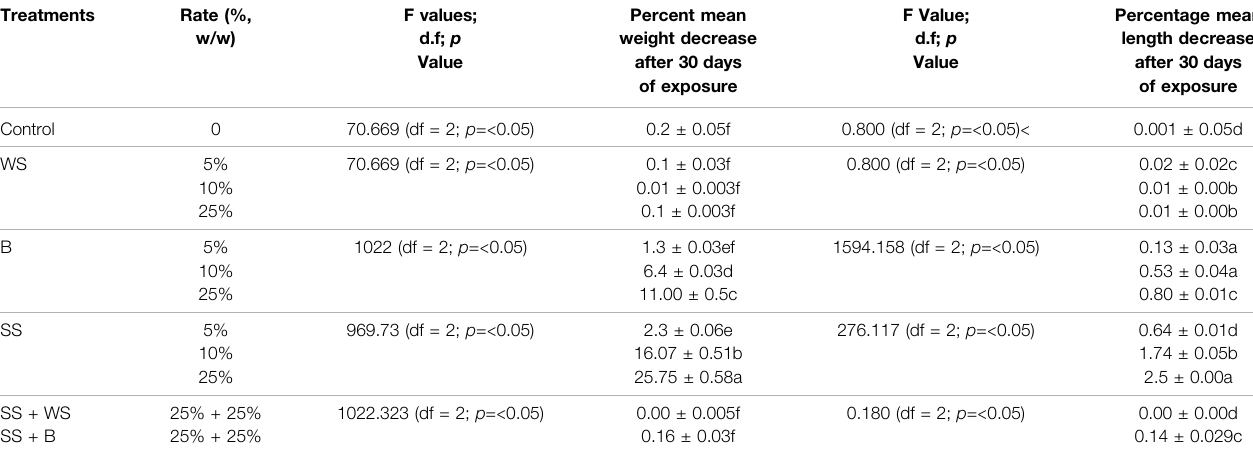
TABLE 1 | Percentage decrease in mean weight and length after exposure to different concentrations of soil amendments in Pheretima posthuma . Treatments